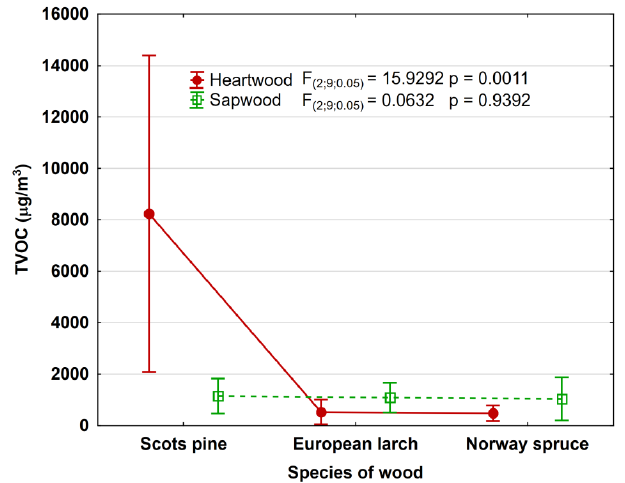
Figure 2. Mean boundary of TVOC concentrations for the heartwood and sapwood of the studied species. Vertical bars denote a confidence interval of 95%.